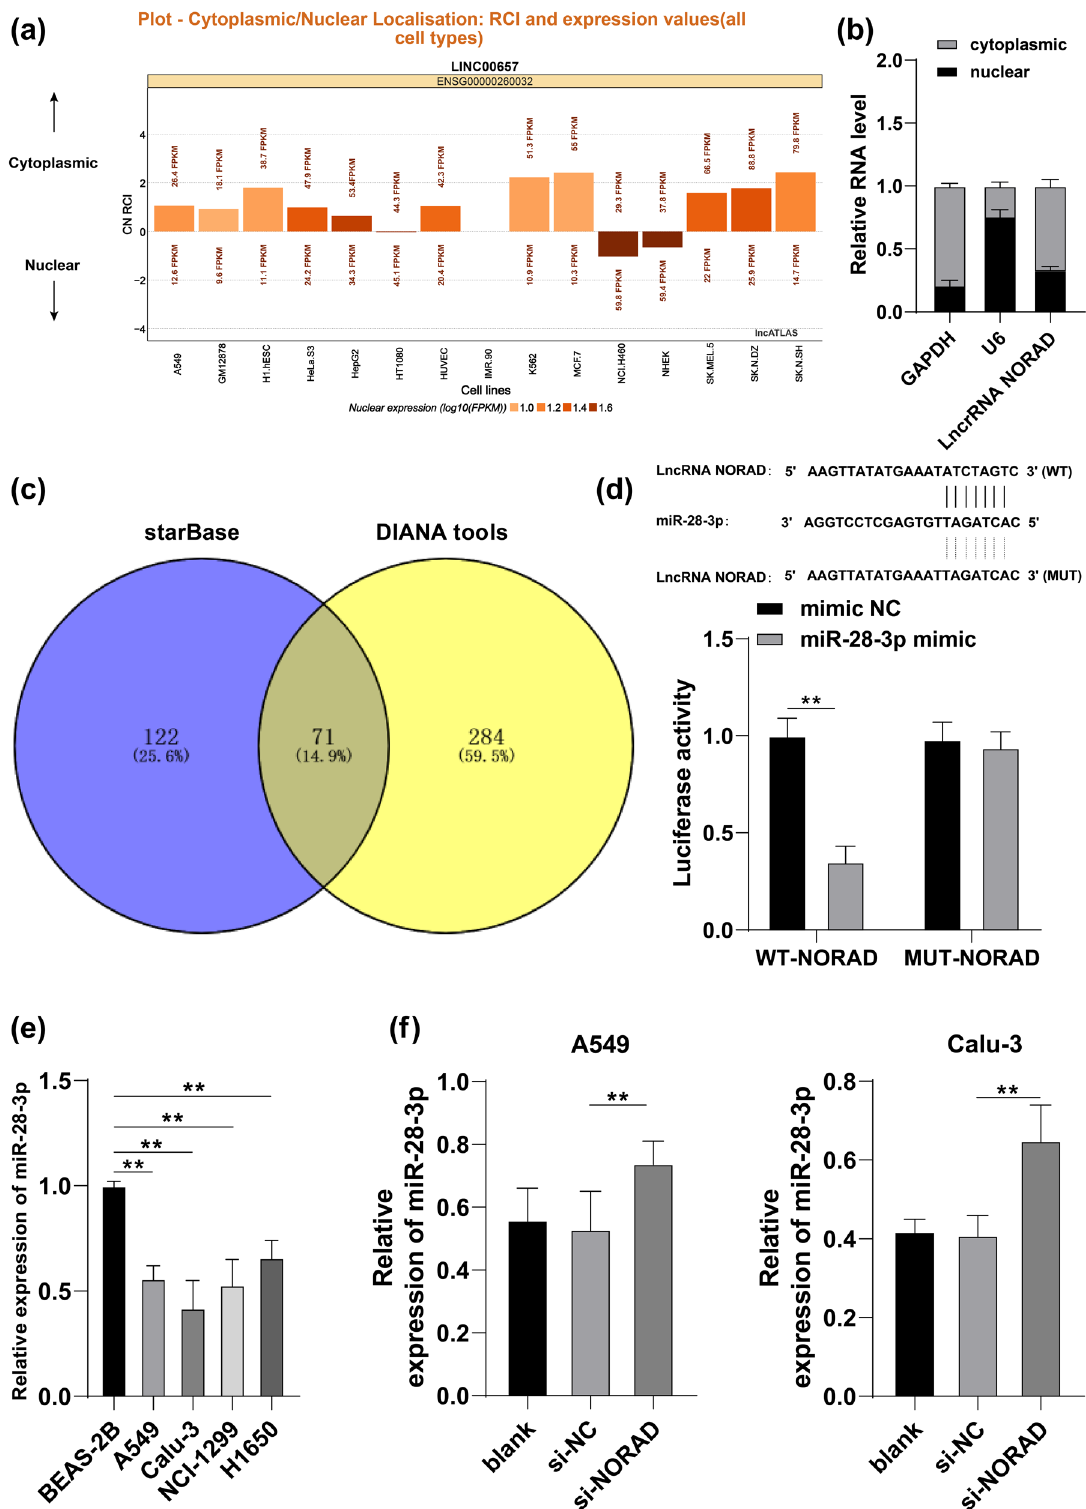
Figure 2: NORAD targets miR - 28 - 3p in LC cells. ( a ) The subcellular localization of NORAD was predicted through the Lncatlas website ( https://lncatlas.crg.eu/ ) . ( b ) The subcellular localization of NORAD in LC cells was veri fi ed by fractionation of nuclear and cytoplasmic RNA assay. ( c ) Downstream target genes of NORAD and the intersections are exhibited by Venn diagram, with blue representing StarBase database ( http://starbase.sysu.edu.cn/?tdsourcetag = s_pcqq_aiomsg ) and yellow representing DIANA tools ( http://carolina.imis.athena - innovation.gr/diana_tools/web/index.php?r = lncbasev2%2Findex - predicted ) . ( d ) Binding sites between NORAD and miR - 28 - 3p and dual - luciferase reporter gene assay. ( e and f ) miR - 28 - 3p expression in LC cells and BEAS - 2B cells as well as cells transfected with si - NORAD was detected by RT - qPCR. The independent cell experiments were repeated three times. The results were presented as mean value ± standard deviation. Two - way ANOVA was appointed to analyze the data in panels b and d and one - way ANOVA was appointed to analyze the data in panels e and f. Tukey ’ s multiple comparisons test was applied for the post hoc test. ** p <